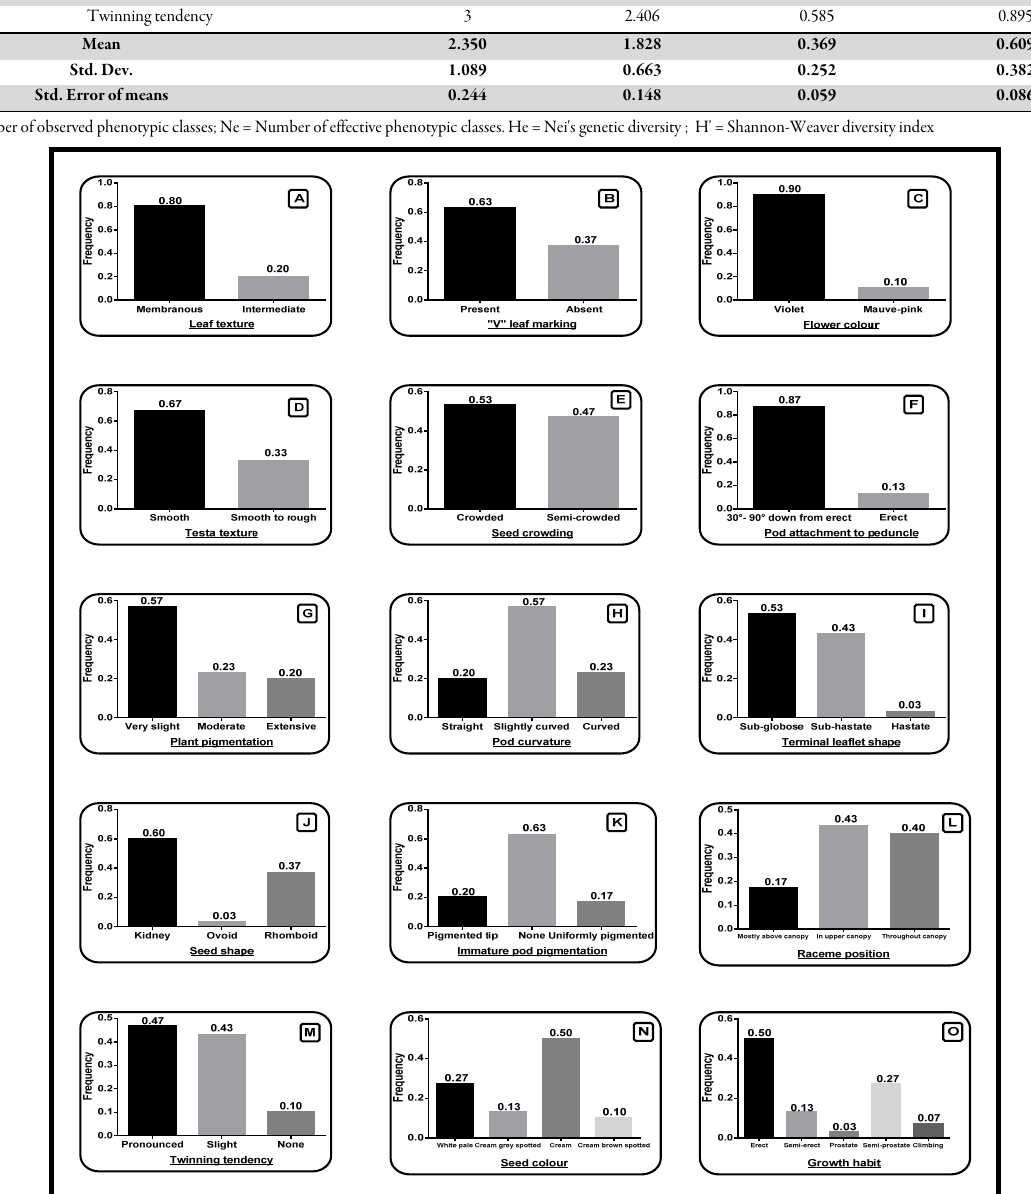
Fig. 1. Phenotypic classes’ frequencies of fifteen polymorphic qualitative traits in cultivated Vigna unguiculata from the Western Region of